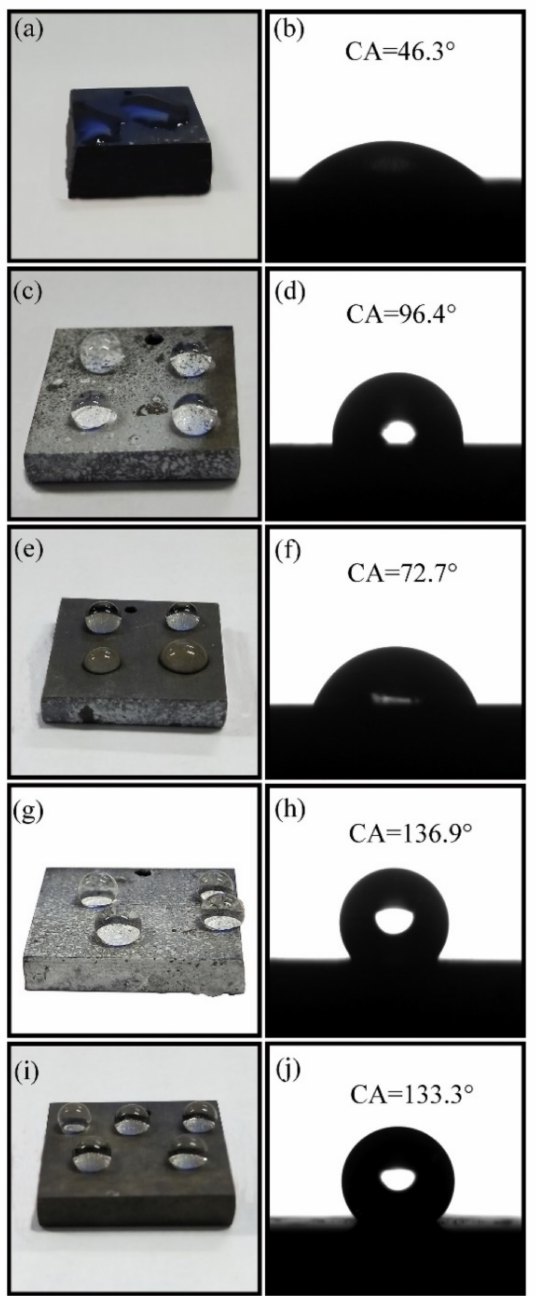
Figure 8. Optical photographs of surface droplets and their corresponding static contact angles: ( a , b ) Mg–Al LDH; ( c , d ) SA; ( e , f ) SL; ( g , h ) MA; ( i , j ) PFSTMS. Reprinted with permission from [65]; Copyright 2015 Nature